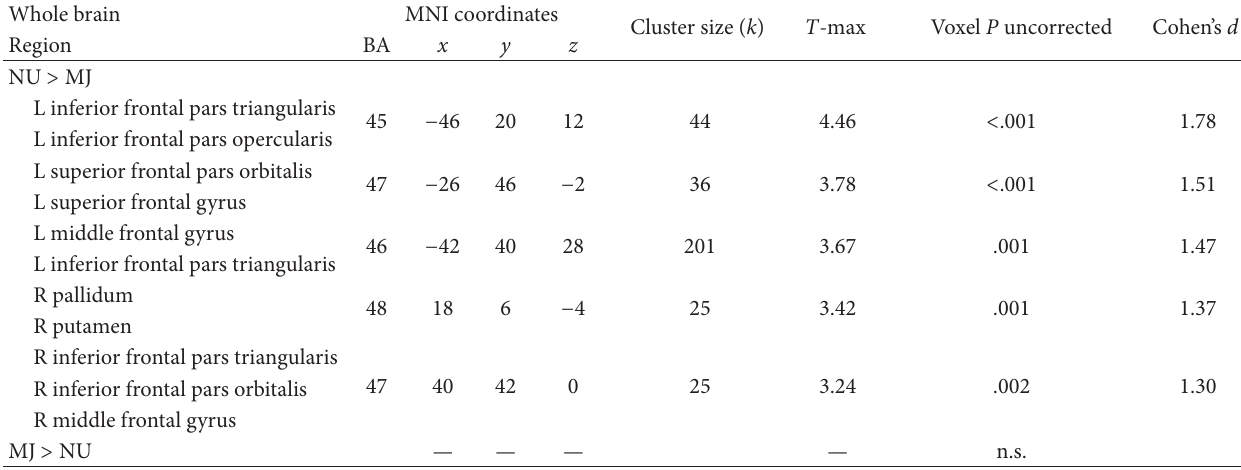
T 3: Foci of maximally activated brain regions—Retrieval-Motor Control.